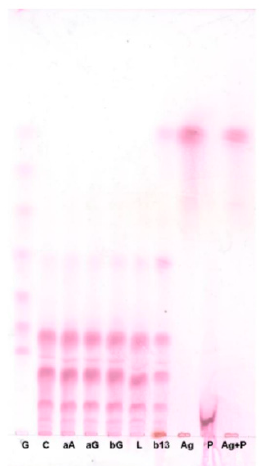
Figure 3. TLC chromatogram of enzymatic analysis of CCK-oligosaccharides. G: G1–G7 standard; C: CCK-oligosaccharides; aA: CCK-oligosaccharides treated with α -amylase; aG: CCK-oligosaccharides treated with α -glucosidase; bG: CCK-oligosaccharides with β -glucosidase; L: CCK-oligosaccharides treated with lichenase; b13: CCK-oligosaccharides treated with β -1,3-D-glucanase; Ag: CCK-oligosaccharides treated with amyloglucosidase; P: CCK-oligosaccharides treated with pullulanase M1; Ag+P: CCK-oligosaccharides treated with amyloglucosidase and pullulanase M1.